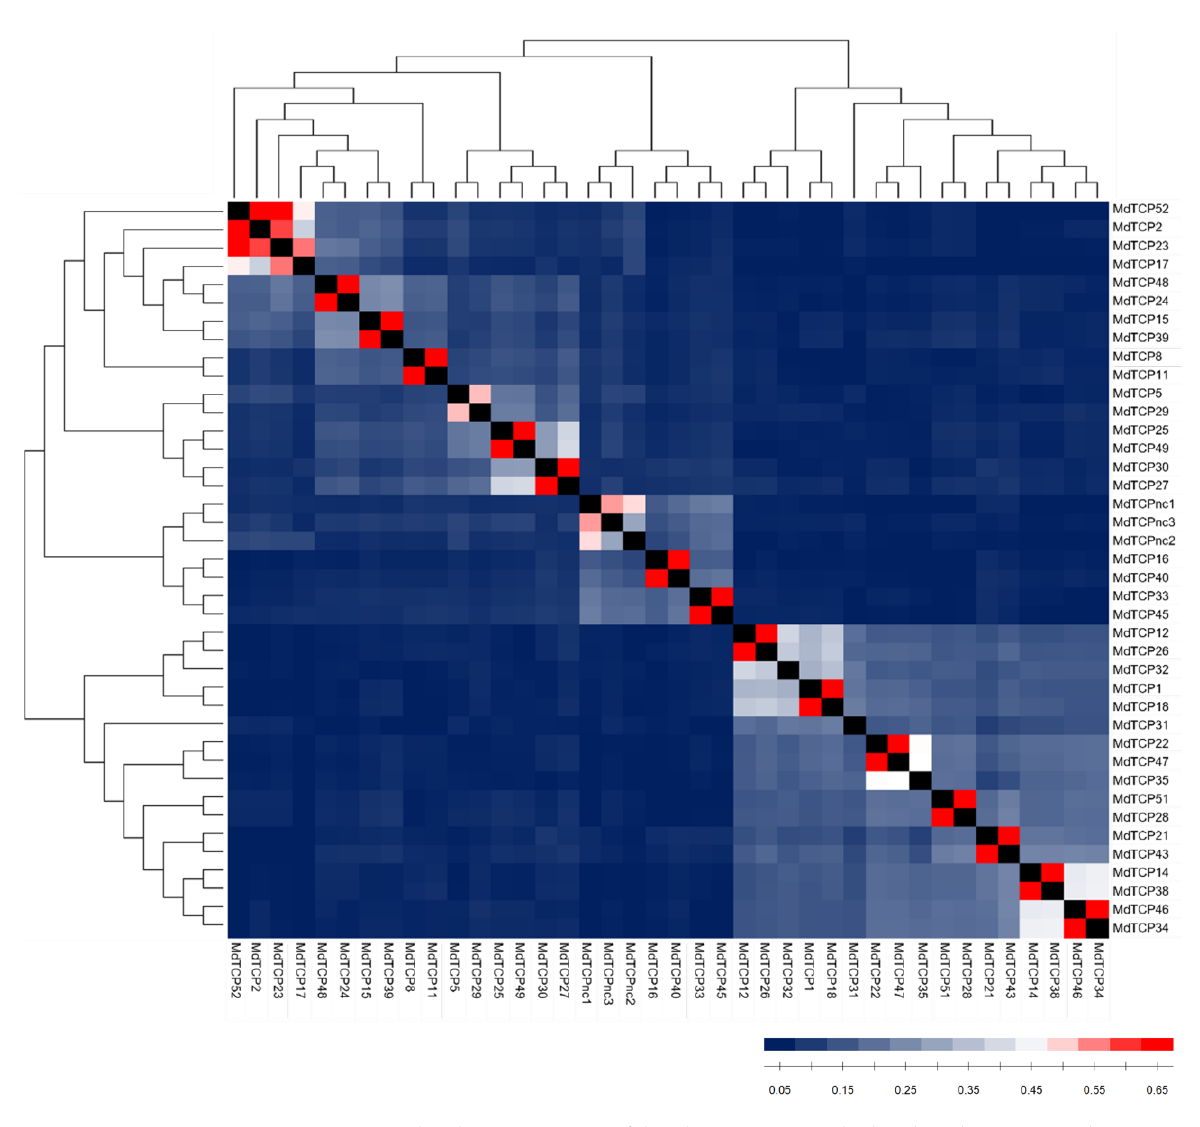
Figure 2. Graphical representation of the identity matrix calculated on the amino acid sequences of the 40 MdTCPs identified. MdTCP identifiers are reported to the right and bottom of each row/column. The phylogenetic relationships among genes are displayed by a neighbor-joining tree on top and to the left. The color gradient of each square indicates a low (blue), moderate (white), or high (red) percentage of identity between two MdTCPs.